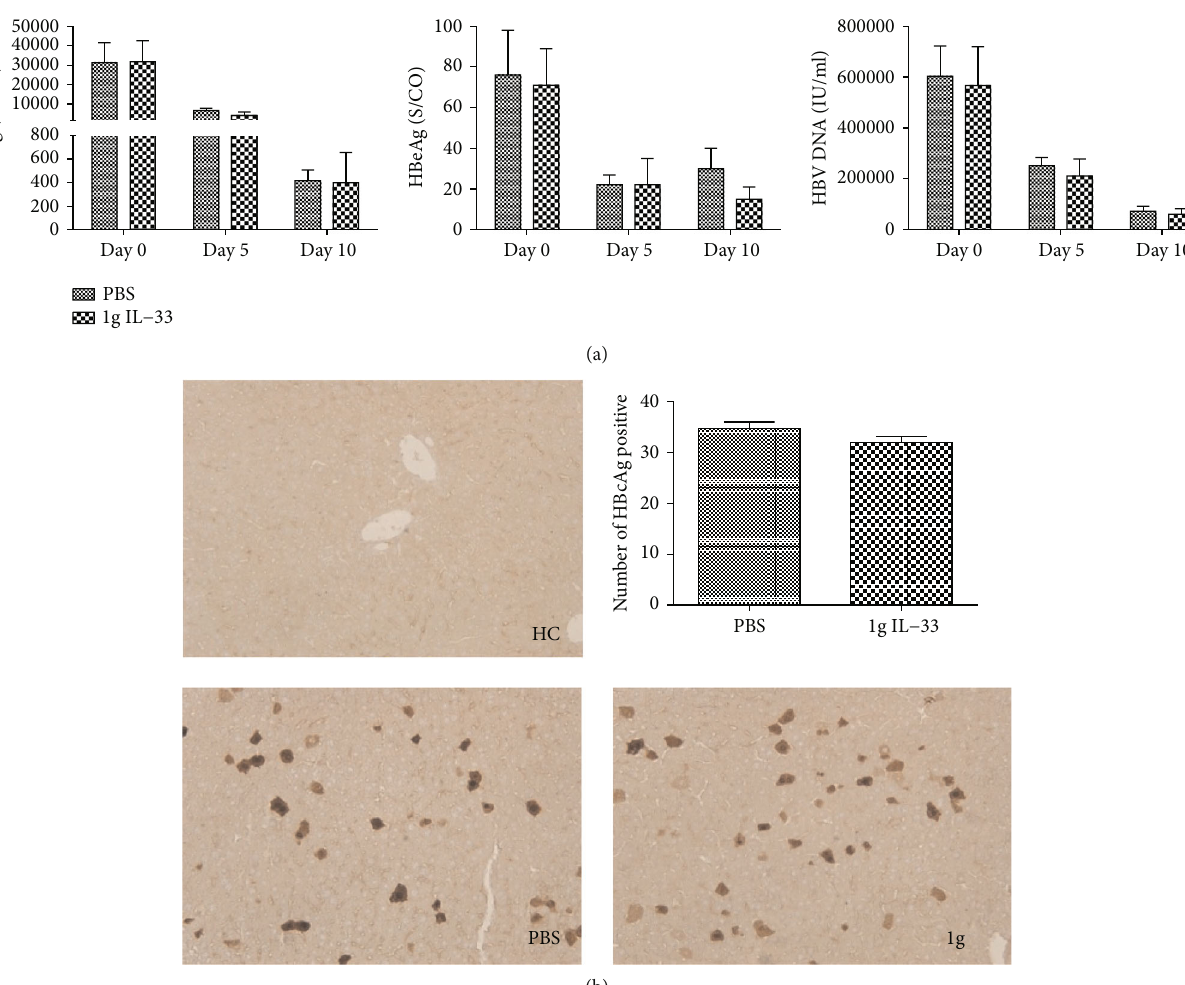
Figure 2: IL-33 has no antiviral e ff ect in ST2 knockout mice. The concentrations of serum HBsAg, HBeAg, and HBV DNA in HBV ST2 knockout mice (a). Images of HBcAg staining were detected by histological study in liver sections from HBV ST2 knockout mice (b). The statistical signi fi cance of the data was determined using the Mann – Whitney test; P value is shown in each